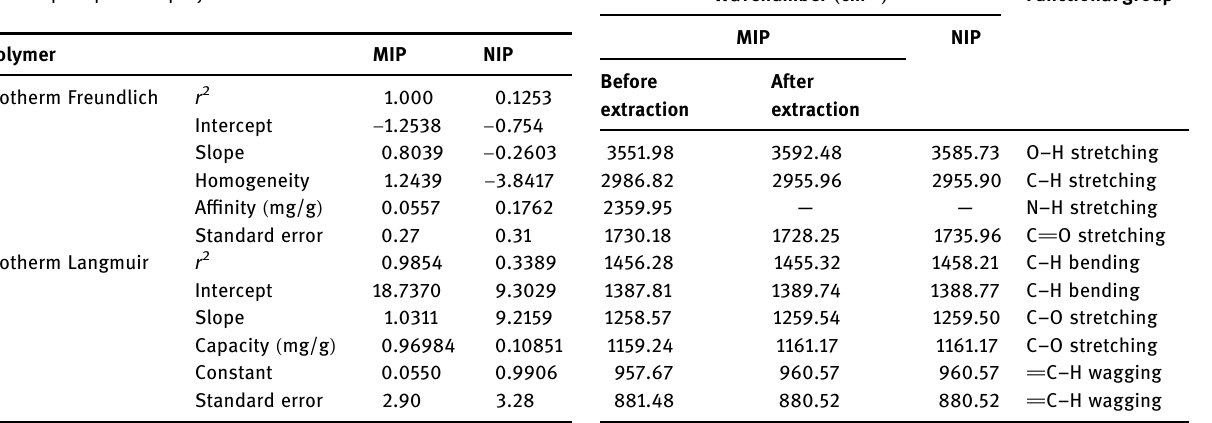
Table 1: The value of isotherm Freundlich and Langmuir parameters on MIP precipitation polymerisation